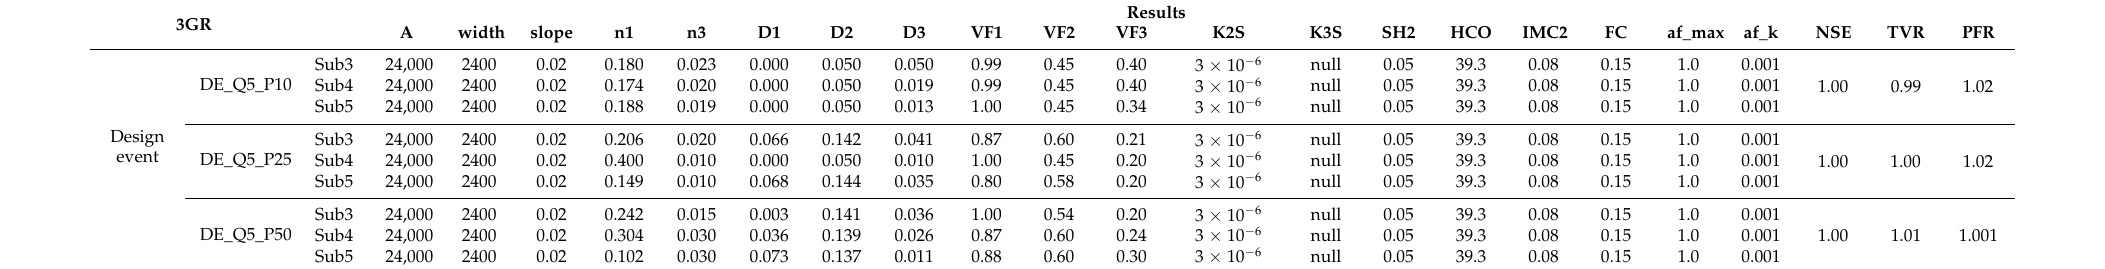
Table A7. The results of the 3GR scenario, which includes three types of a green